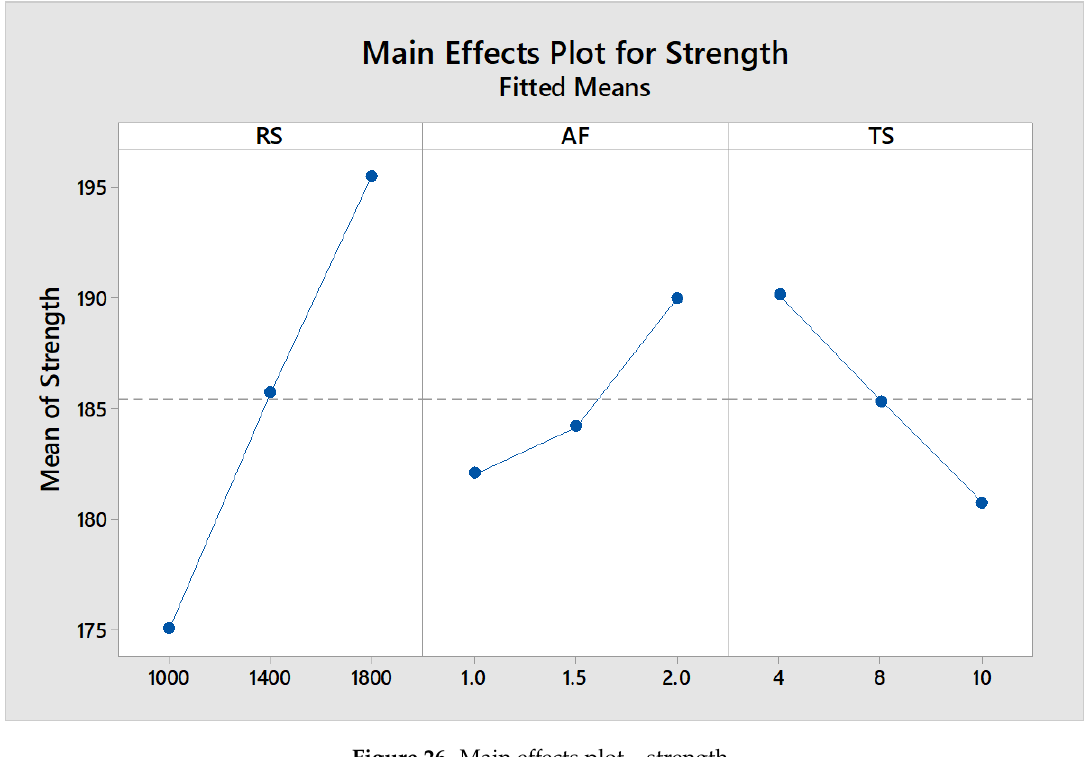
Figure 26. Main effects plot — strength.